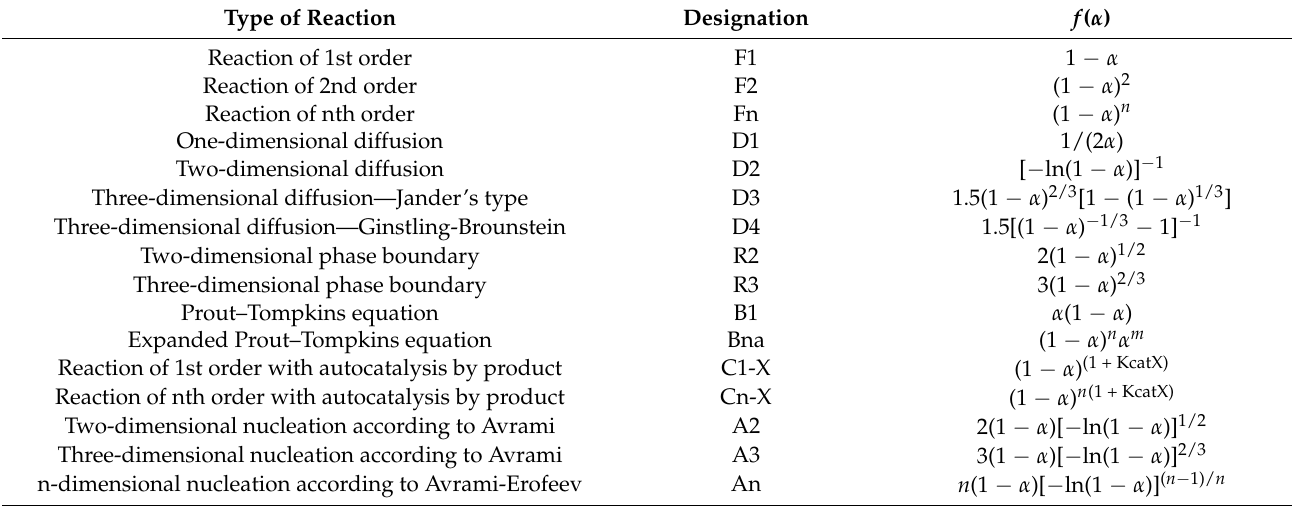
Table 1. The most common types of reactions and the corresponding equations of kinetic models in two equivalent notation forms